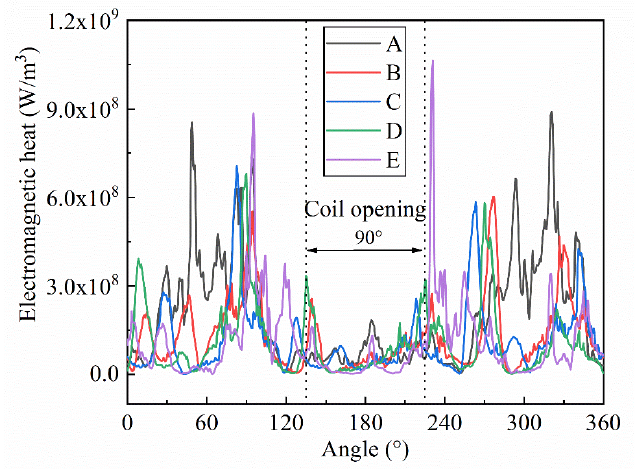
Figure 15. Electromagnetic heat distribution curve of the tooth surface under LC heating.